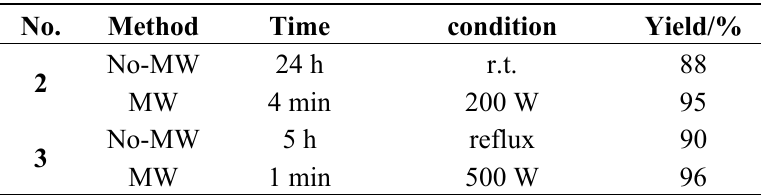
Table 1. Comparison of yields of intermediates through methods with or without microwave